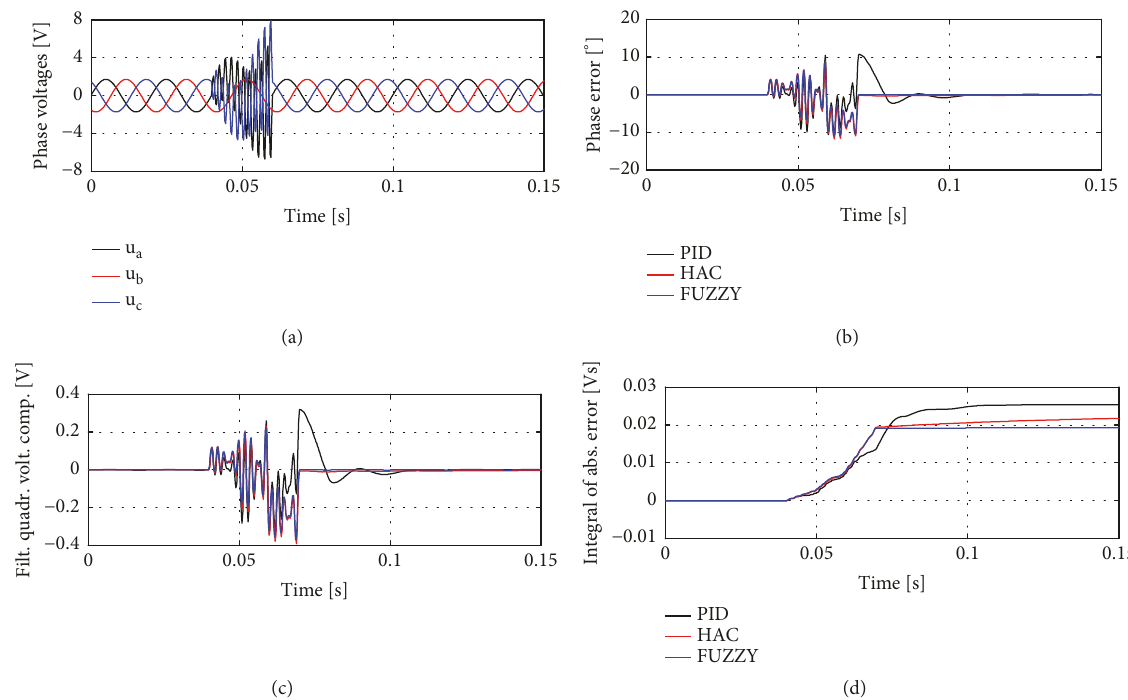
Figure 12: Phase voltages (a), phase error (b), filtered quadrature voltage component 𝑢 𝑞 (c), and integral of absolute error (d) for the unbalanced low-frequency transient in phase voltages.